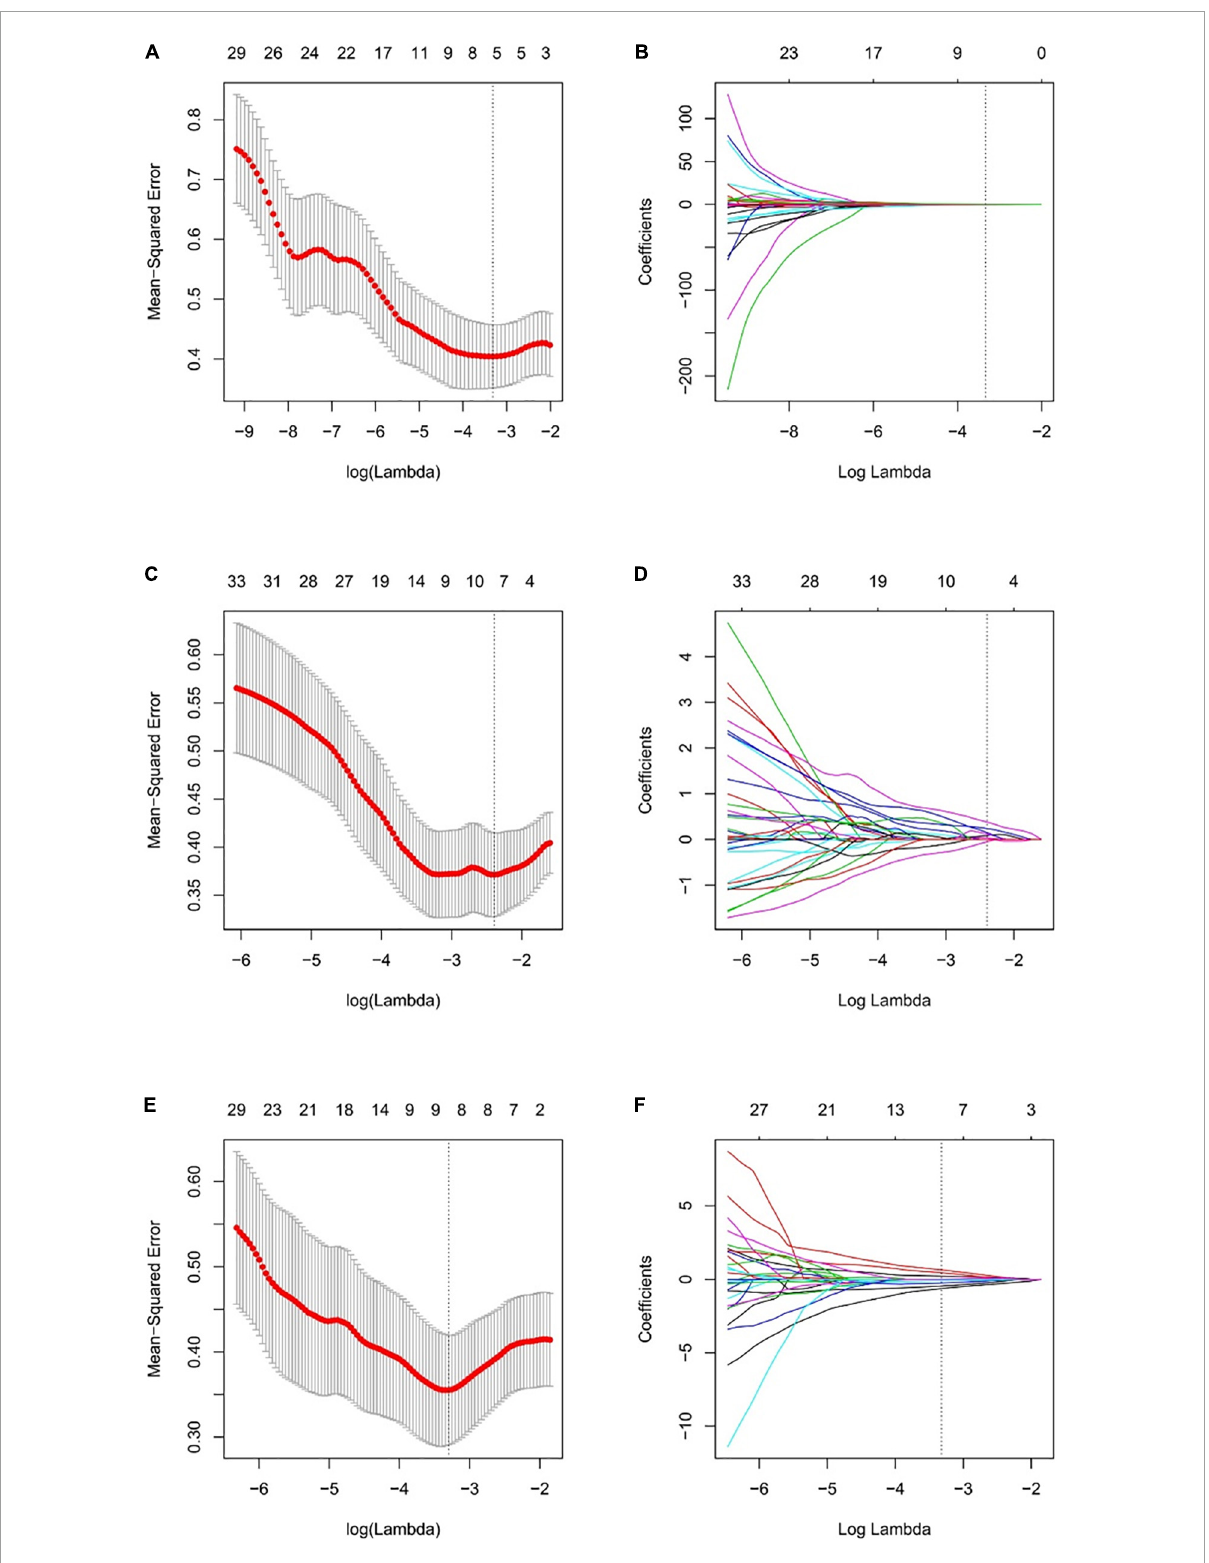
FIGURE3 Selection of the radiomic features using LASSO regression. Selection of the optimal tuning parameter lambda through 10-fold cross-validation with the minimal mean-squared error criteria for the basal level (A) , middle level (C) , and apical level (E) radiomic features. (B) The coefficient profile plot of 5 in basal level (B) , 7 in middle level (D) , and 8 in apical slice (F) non-zero coefficients against the optimal log(lambda)